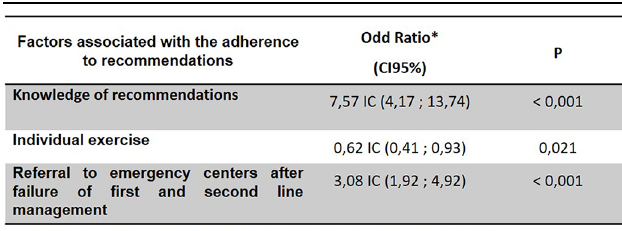
Table I. Factors in fl uencing adherence to the ANSM